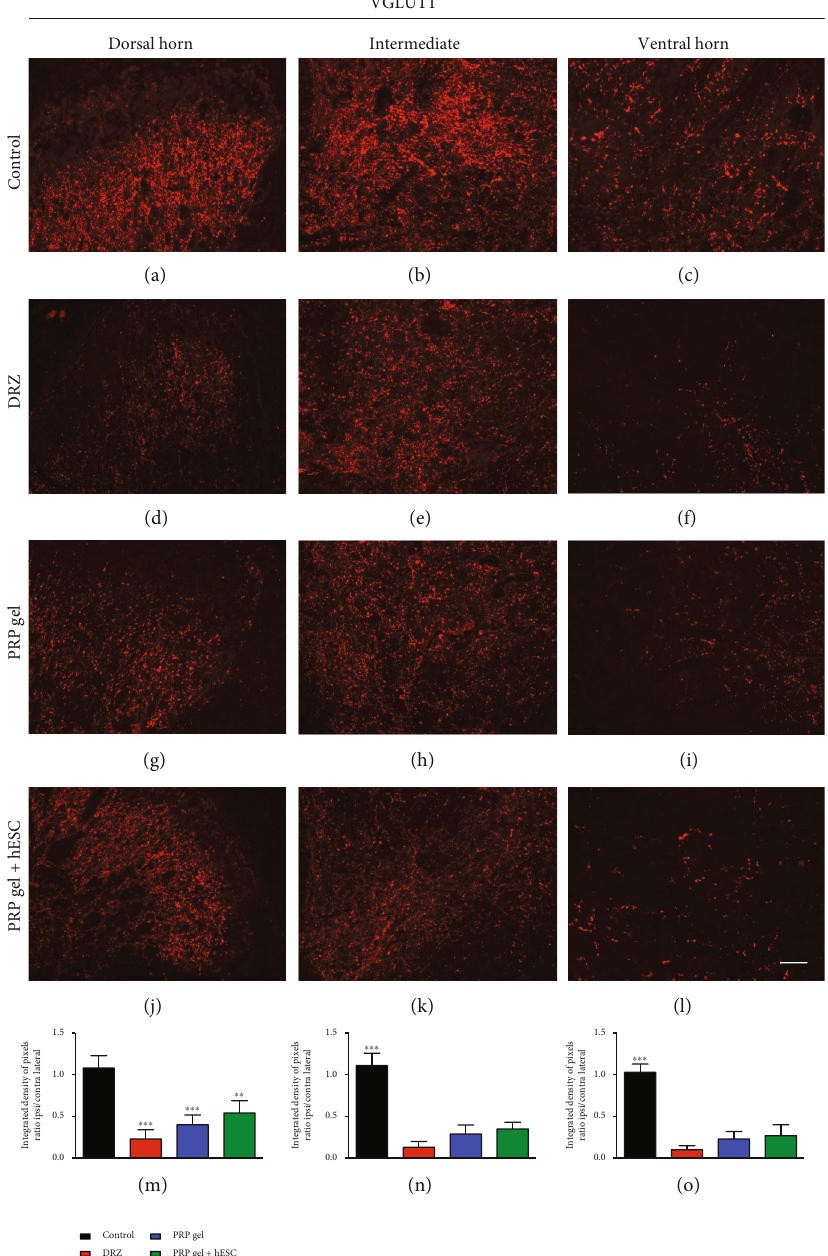
Figure 4: Representative immuno fl uorescence micrographs of VGLUT1 (glutamatergic synapses) immunolabeling on the ipsilateral side of the spinal cord after rhizotomy and repair, 1 week after lesion induction. A signi fi cant decrease in glutamatergic synaptic density was observed following DRZ. However, the “ hESC ” group showed great improvement in punctate labeling in comparison to the DRZ group. Scale bar = 50 μ m